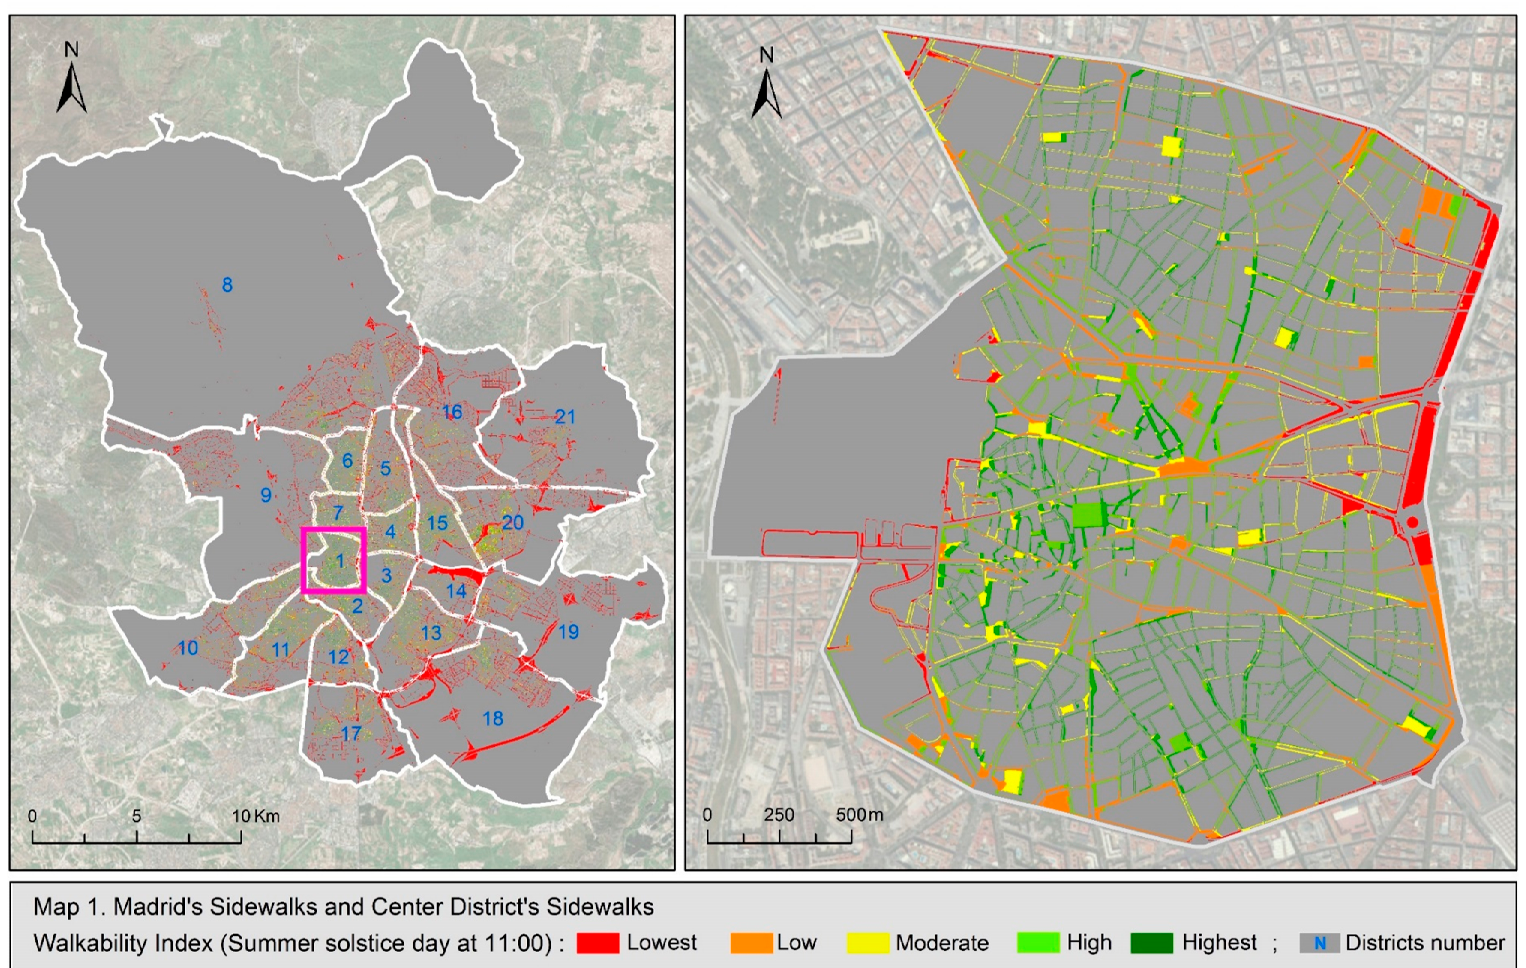
Figure A2. Walkability index results in the entire city and in the central district (detail) at 11 am on summer